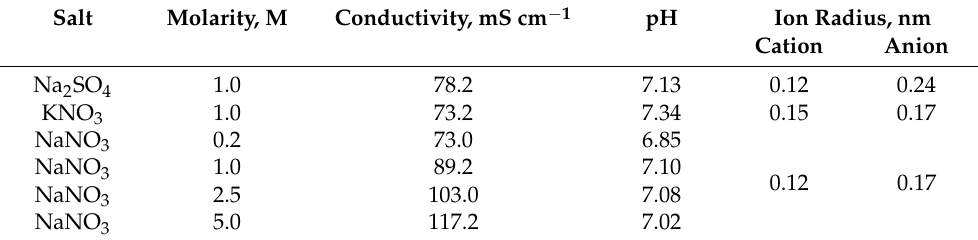
Table 2. Conductivity, pH values and ion sizes [30] for used aqueous